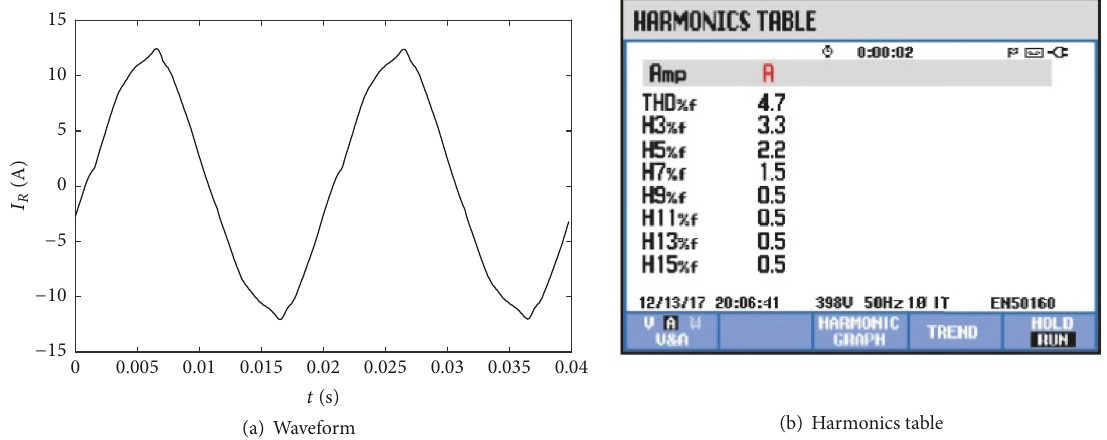
Figure 8: Waveform and harmonics table of current on ac side without harmonic mitigation strategy.